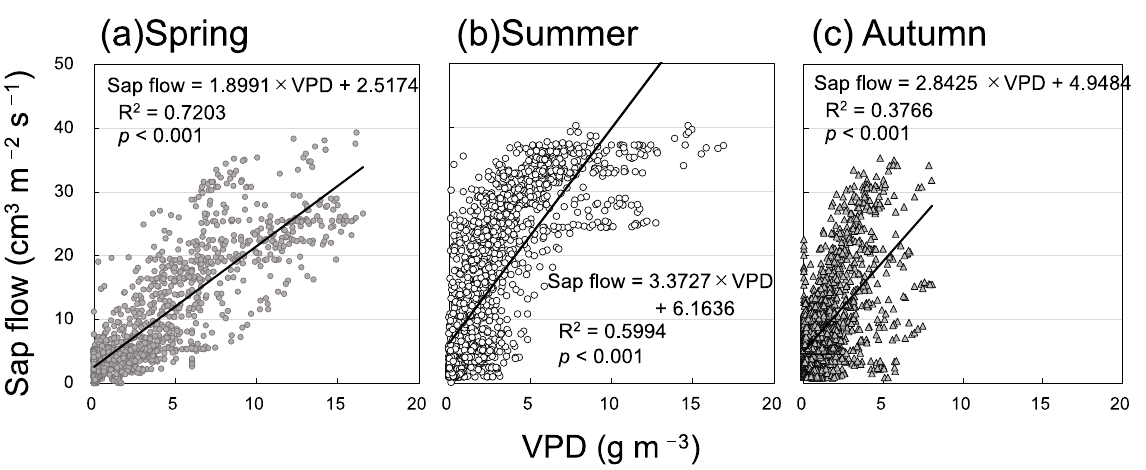
Figure 7. Relationship between sap flow and vapor pressure deficit (VPD) in ( a ) spring, ( b ) summer, and ( c ) autumn.